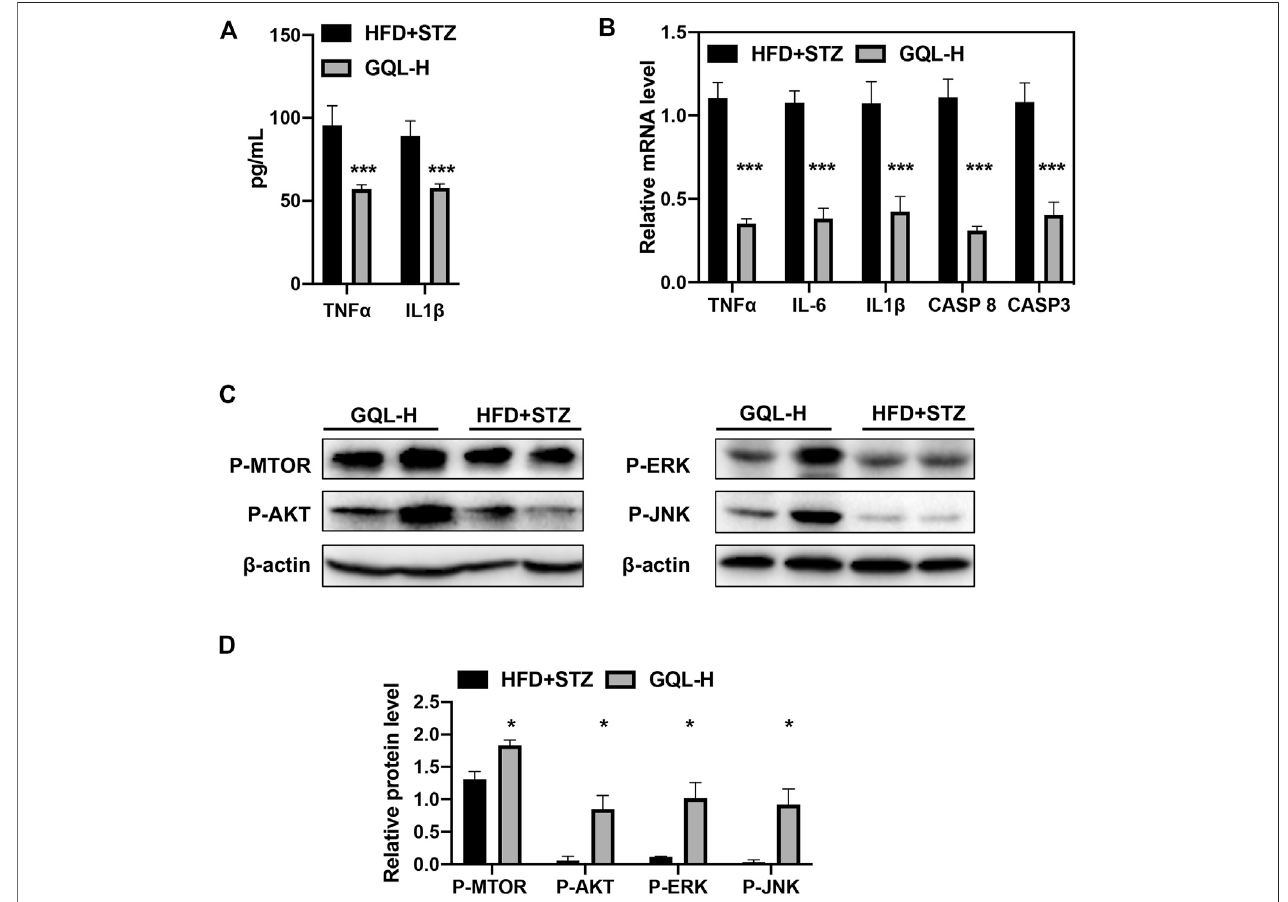
FIGURE 6 | (A) Serum TNF α and IL1 β ; (B) levels of TNF α , IKK α , IL-6, IL1 β , CASP 8, CASP3, and AP-1 mRNA in diabetic mice determined using RT-PCR; (C,D) relative levels of P-AKT, P-MTOR, -JNK, and P-ERK proteins detected by